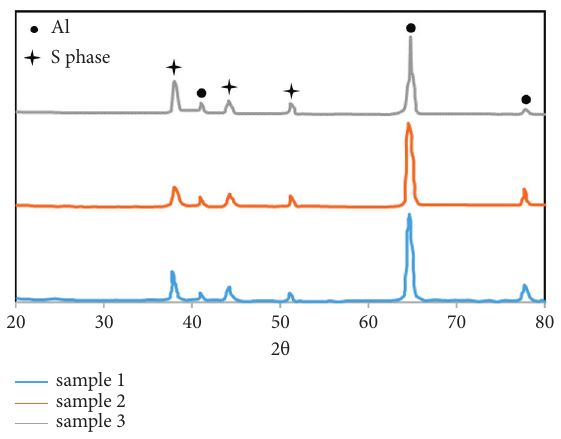
Figure 10: XRD results of all specimens. Table 5: Brinell Hardness